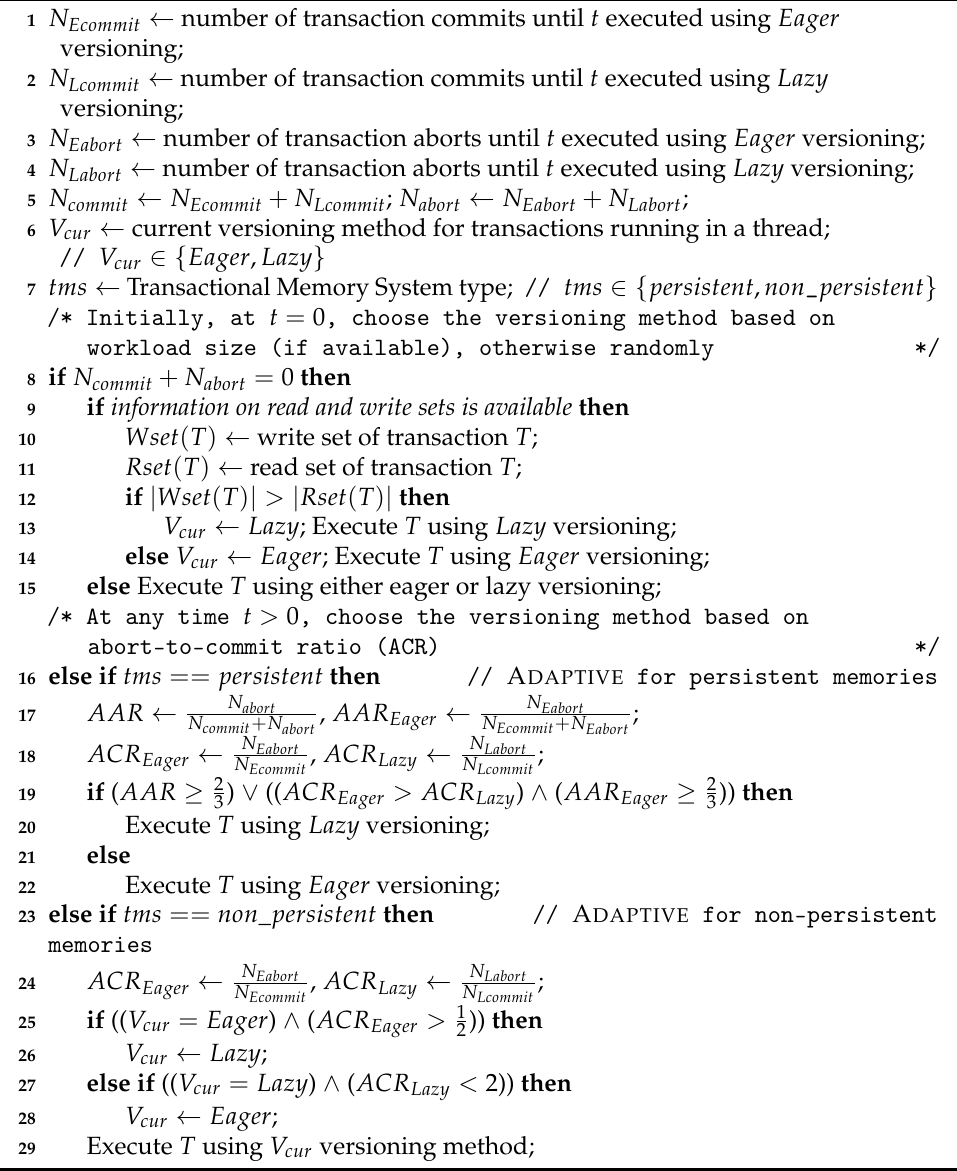
Algorithm 1: A DAPTIVE for a transaction T at any time t ≥